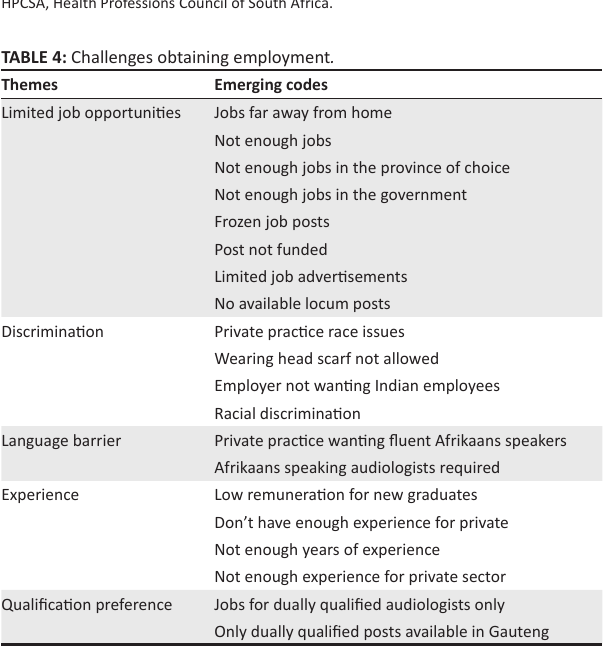
TABLE 4: Challenges obtaining employment